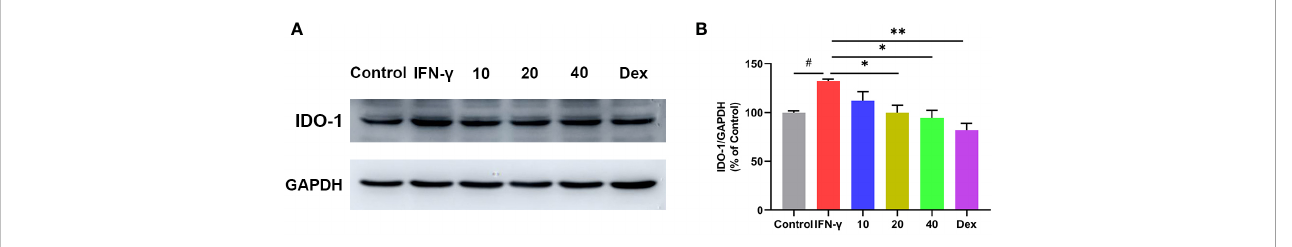
FIGURE 8 Effect of CA on the protein expression of IDO-1 in INF- g induced RAW264.7 cells. Representative western blotting image (A) , and the relative protein expression was normalized to GAPDH (B) . Data are shown as the mean ± SEM of three independent experiments. # P < 0.05 vs. Control group, * P < 0.05, ** P < 0.01 vs. INF- g